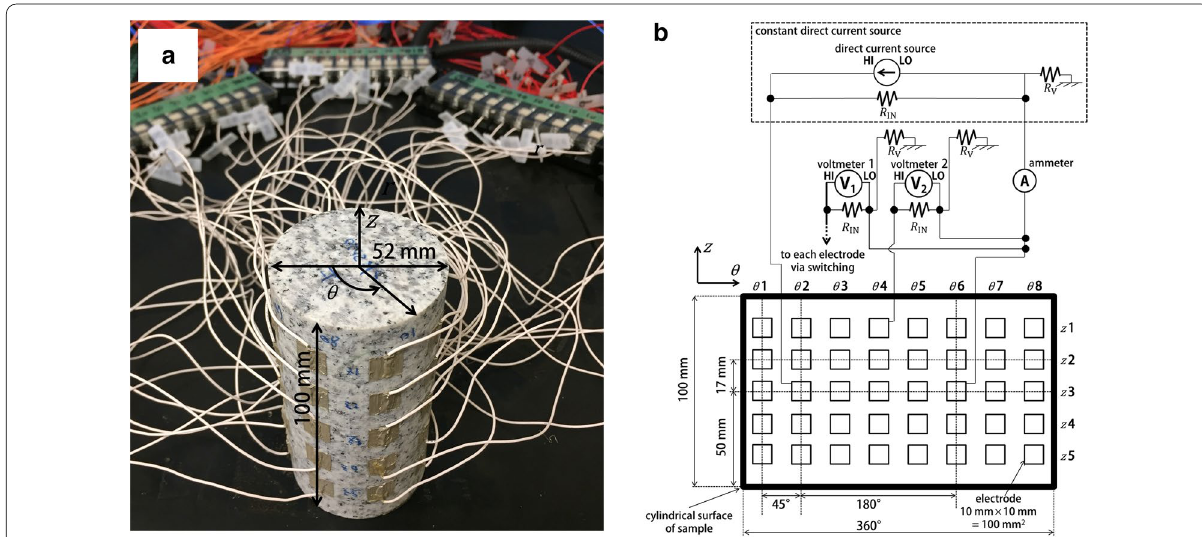
Fig. 12 Photograph and schematic diagram of the measurement set-up with an array of electrodes. a Cylindrical rock sample (52 mm diameter and 100 mm length) overlaid with the dimensions r , θ , and z defining its coordinate axes. Electrodes were attached to the cylindrical surface, and wires attached to electrodes provided a connection for measuring instruments. b Measurement scheme. z and θ are coordinates defined in Fig. 10a. The dotted square is a constant direct current source, R IN is input resistance, R V is insulation resistance between the negative terminal and chassis ground, HI labels positive terminals, and LO labels negative terminals. The direct current source (Model 6243, ADC; Saitama, Japan) injected a known constant current. An ammeter (Model 3458A, Keysight; Santa Rosa, California, US.) monitored the amount of injected current. Electrometers (Model 6514, Keithley; Cleveland, Ohio, USA) with R IN 200 TΩ acted as the =